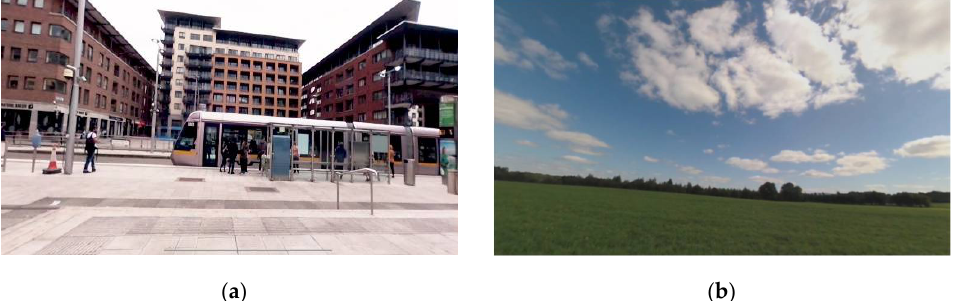
Figure 2. Contextual settings for the sensory evaluation of chocolate: ( a ) VR busy city (Dublin, Ireland) and ( b ) VR Irish